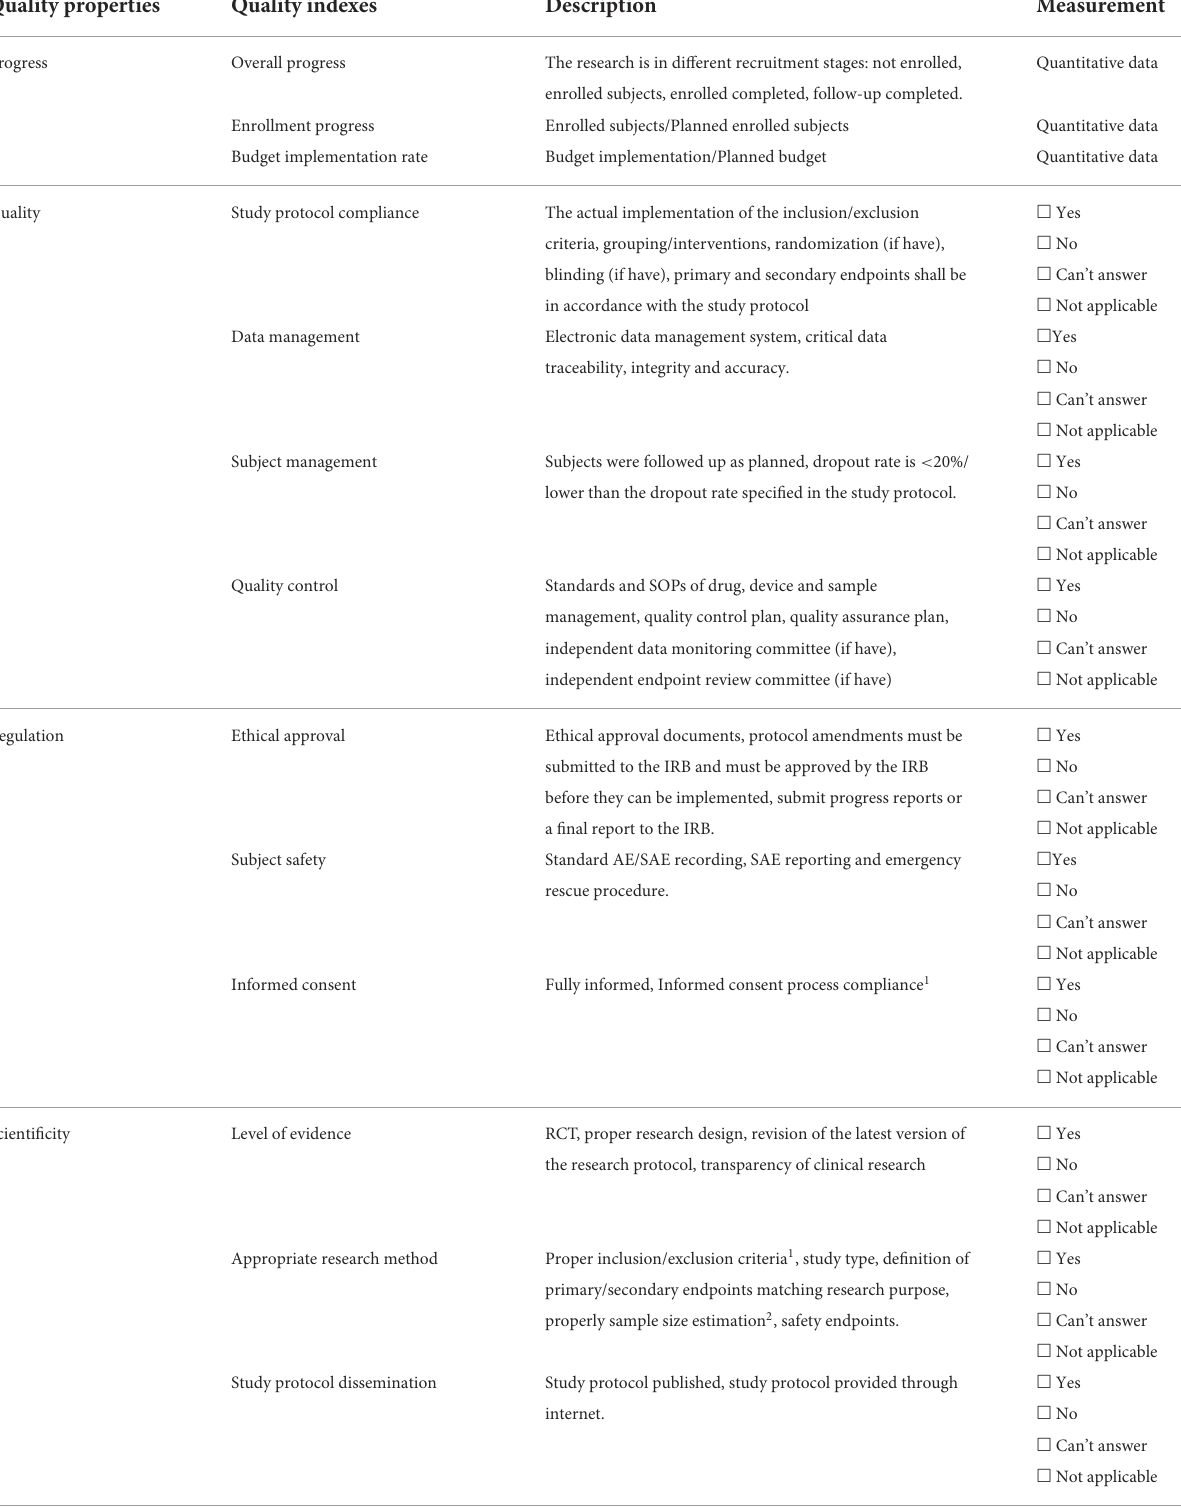
TABLE 1 Framework of quality properties and indexes of quality assessment tool for